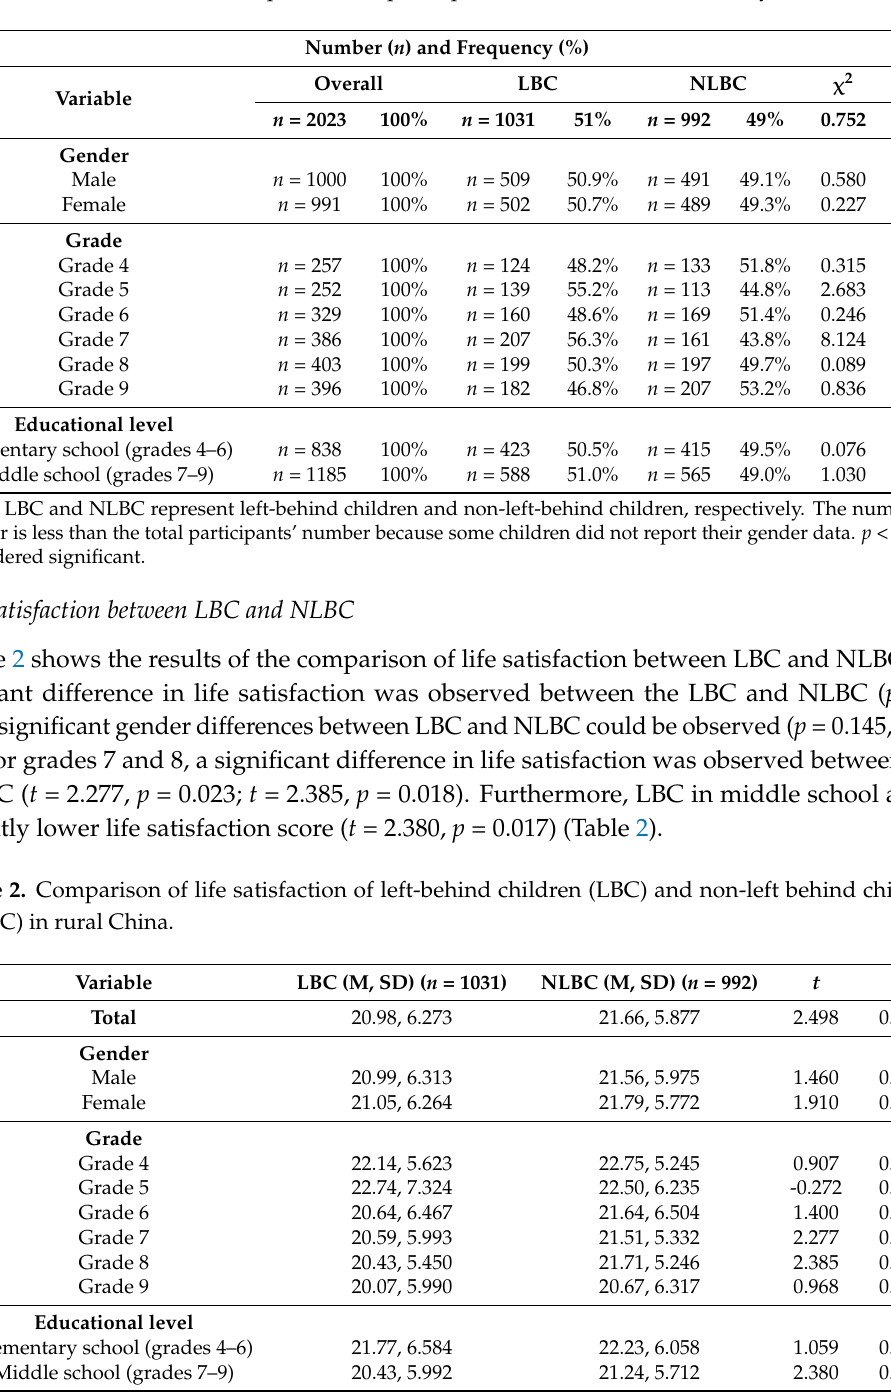
Table 1. Description of the participant characteristics in this study.